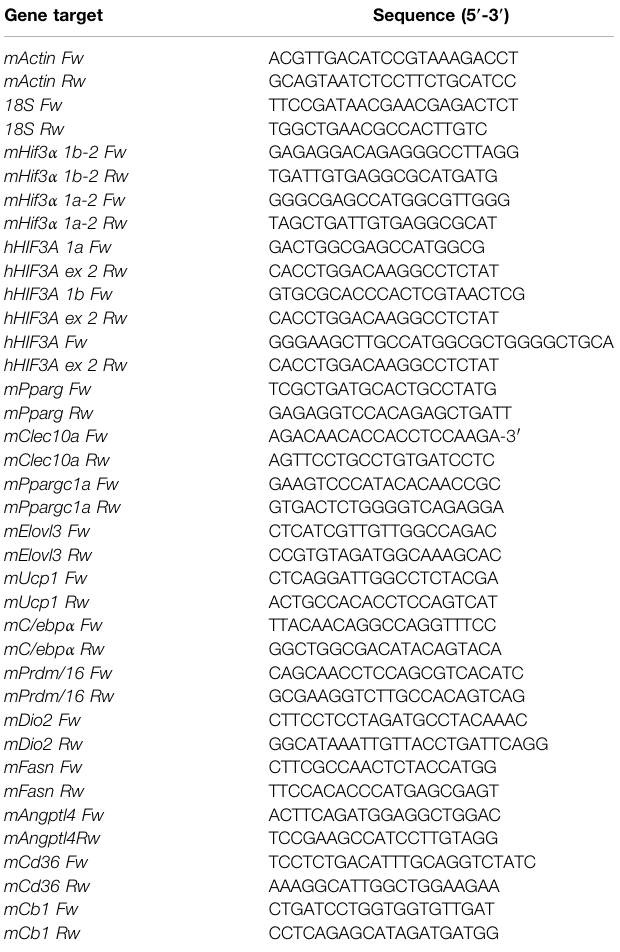
TABLE 1 | Oligonucleotides used in the